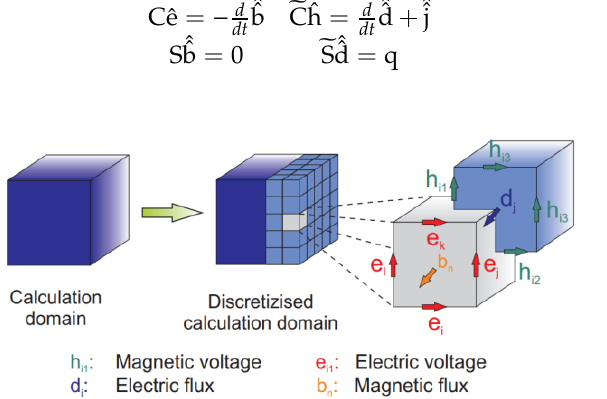
Figure 3. Dual discretization grids with the allocation of voltage and flux components in the mesh.